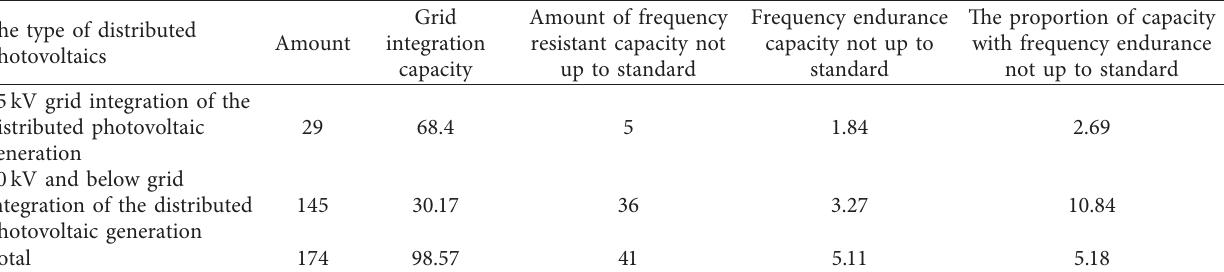
Table 3: Statistical analysis results of frequency endurance capability.